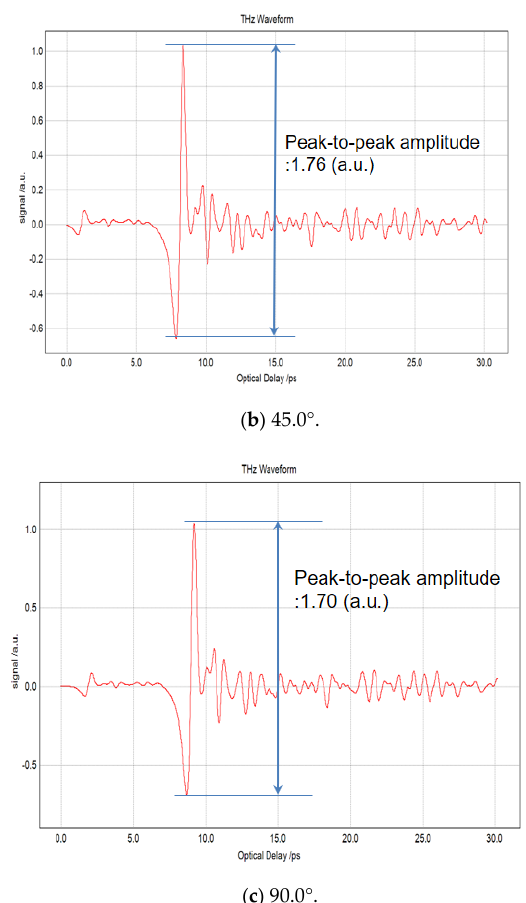
Figure 6. Angular dependence of reflection power of T-rays for carbon-skin honeycomb composite panels.